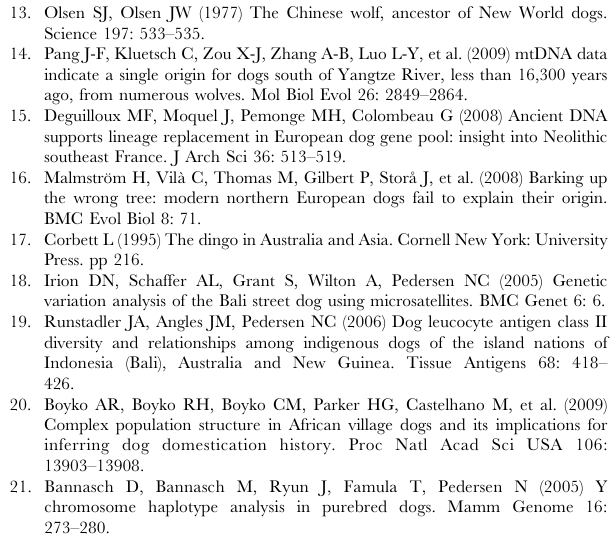
Table S1 List of Sequenom PCR primers developed for SNP loci, which correspond to Natanaelsson et al. 2006 a . Table S2 Sequenom SNP extension primer sequences and expected extension products, developed for SNP loci, which correspond to Natanaelsson et al. 2006 a . Table S3 Frequency of 402 bp mtDNA haplotypes of village dogs sampled in 7 populations. Haplotypes are named as the lowest-numbered previously named synonymous 582 bp haplotype Savolainen et al. 2002 a and Pang et al. 2009 b or are novel in this study (haplotype names beginning with ‘‘V’’); see Table S4 for additional information on novel haplotypes. Table S4 Seventeen novel mtDNA haplotypes, location of sample, and number of substitutions differing from the nearest published haplotype. Sequences were deposited in Genbank (Accession Nos. HQ287728–HQ287744, respectively, in order presented below). Table S5 Number of individuals ( n ), number (No.) of mtDNA haplotypes, and rarified haplotype richness (corrected for differing sample sizes to n = 10) for 402 bp mtDNA D-loop haplotypes of village dog sam- pling locations in the Middle East and Southeast Asia. Table S6 Y chromosome SNP haplotypes as resolved from 11 ‘‘Ydog’’ loci (Natanaelsson et al. 2005 a ). Haplotypes 1–9 have been described previously in terms of these and additional loci and haplotypes 10–12, named in this study, were represented previously as unsampled, unnamed nodes. Table S7 Imputed Y-SNP haplotypes corresponding to the 23 (of 120 total) Y-STR haplotypes for which 1 or more of the 11 SNPs failed (indicated by ‘‘-’’) or for which no SNP genotyping was attempted. All but one incomplete SNP haplotype corresponded to the same failed locus and the same haplotype ambiguity (7 or 11), suggesting a mutation